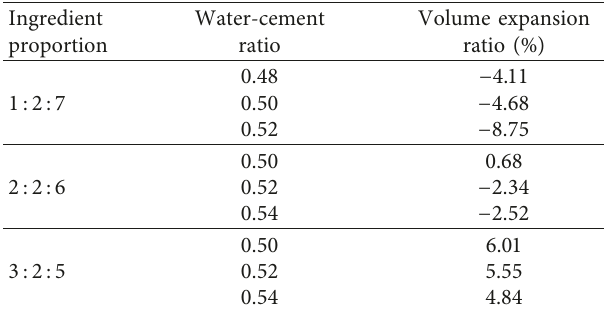
Table 2: Expansion ratios of different grout concretions over 28d.